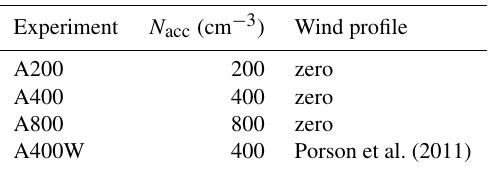
Table 2. Radiation fog model experiments with their key configu- ration details. N acc is the number concentration of accumulation- mode